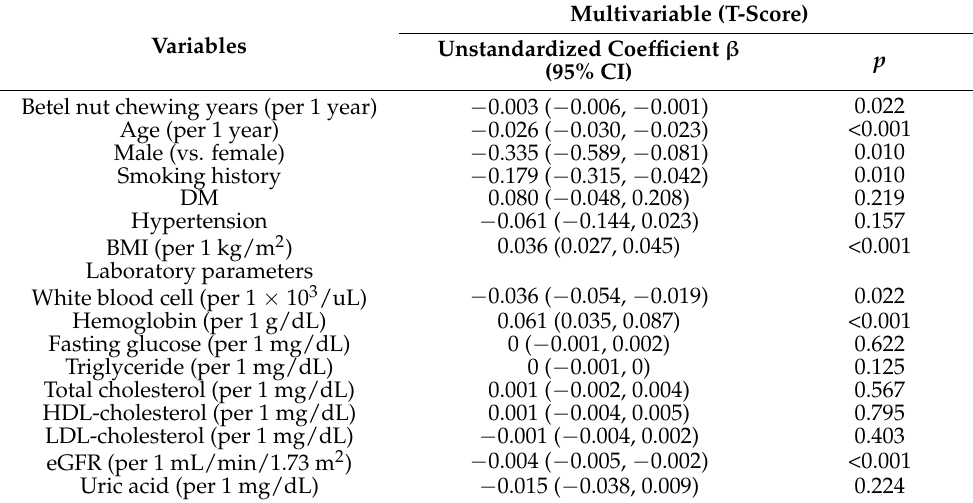
Table 3. Association of betel nut chewing years with baseline calcaneus ultrasound T-score in study participants with betel nut chewing history (n = 7210) using multivariable linear regression analysis.